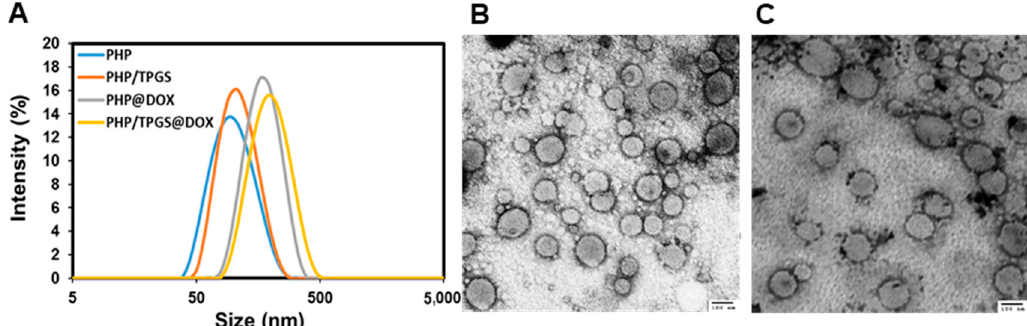
Figure 3. Diameter and size distribution of blank micelles and DOX-loaded micelles by dynamic light scattering (DLS) ( A ) and TEM micrograph of blank PHP micelles ( B ) and PHP/TPGS micelles ( C ). The scale bar is 100 nm.